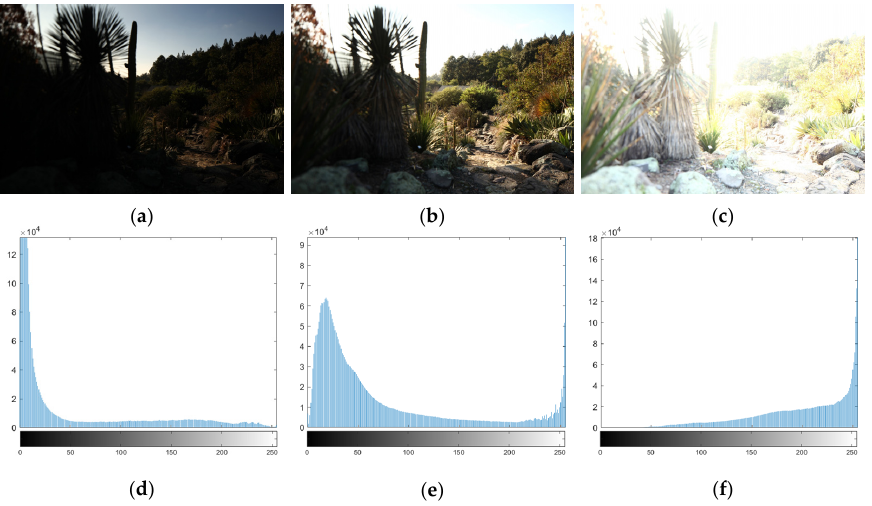
Figure 5. Multi-exposure images and histograms: ( a ) under-exposure image; ( b ) correct-exposure image; ( c ) over-exposure image; ( d ) histogram of under-exposure image; ( e ) histogram of correct- exposure image; ( f ) histogram of over-exposure image.